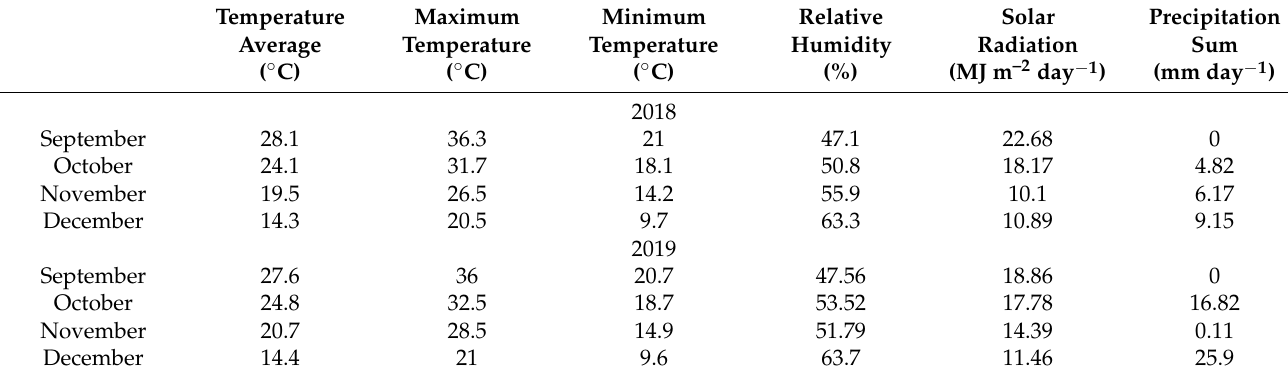
Table 2. Monthly averages of the climatic data in the experimental site during the seasons of 2018 and 2019.